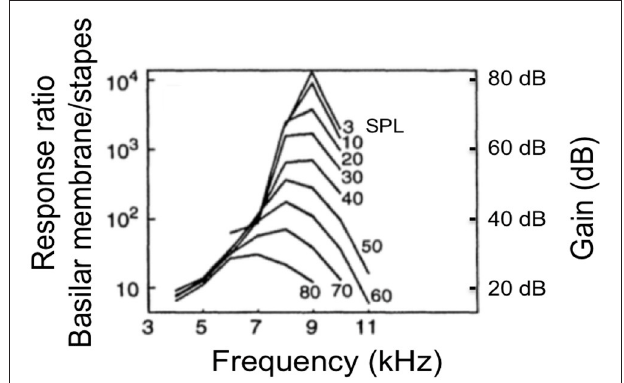
FIGURE 1 | The frequency response measured from a chinchilla cochlea for various levels input strength measured in dB of sound pressure level (SPL) adapted from (Ruggero, 1992). The gain is measured by the BM displacement (or velocity) relative to the stapes